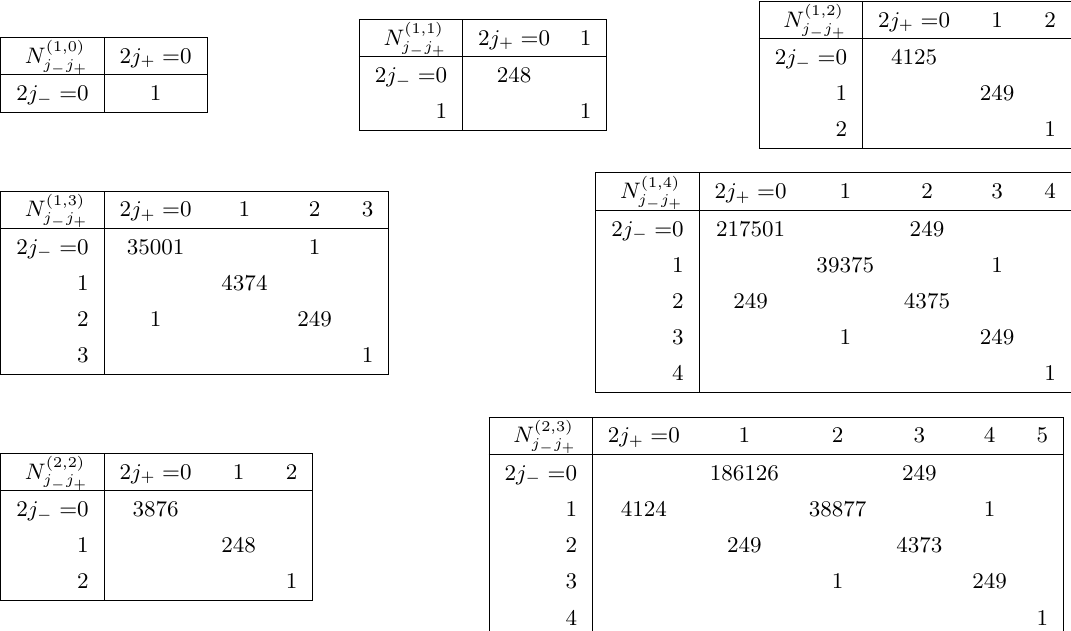
Table 4 . Refined BPS invariants of the massless E-string at base degrees b = 1 , 2 and e